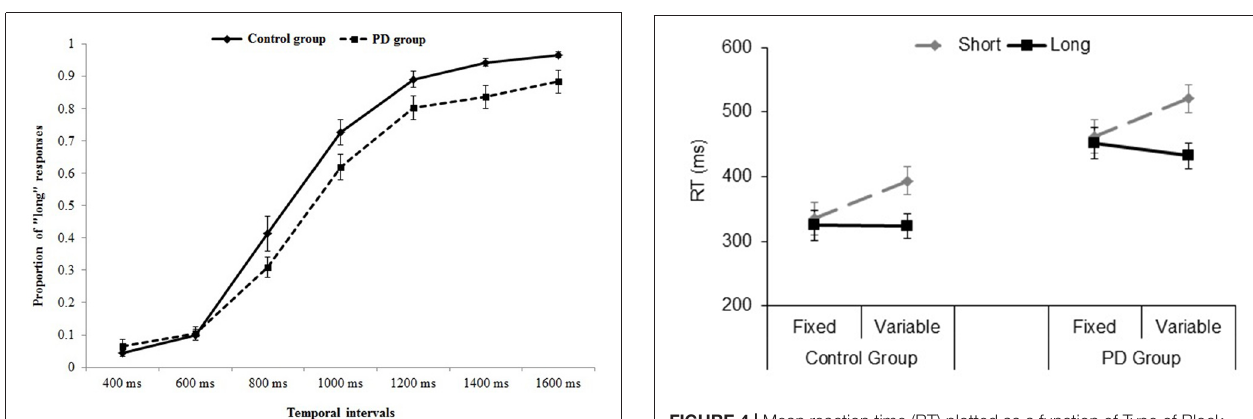
FIGURE 4 | Mean reaction time (RT) plotted as a function of Type of Block (fixed, variable) and Foreperiod (short, long) in the Control group and PD group. Error bars represent the standard error of the